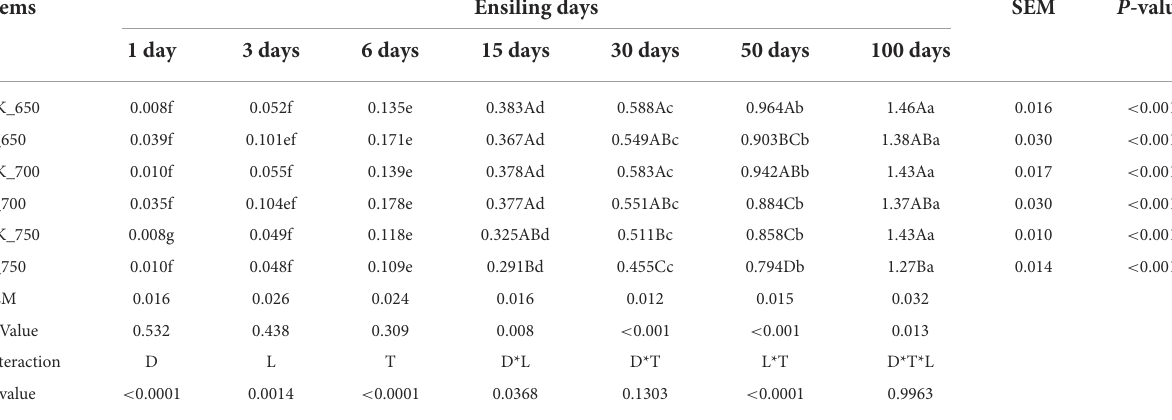
TABLE 2 Fermentation weight loss (% based on fresh weight) of sweet sorghum silages during the fermentation process ( n =